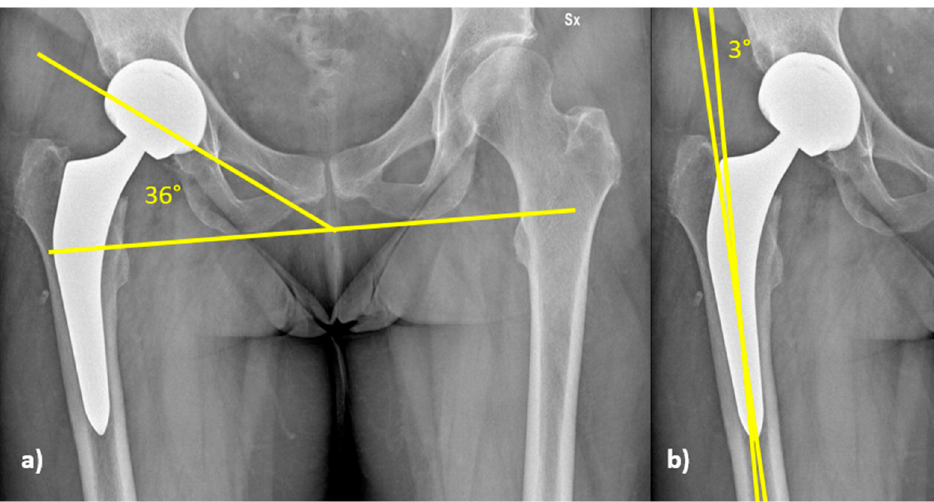
Figure 4. ( a ) Cup inclination is measured as the angle between the line tangent to the border of the acetabular cup and a line parallel to the horizontal plane. ( b ) Stem alignment is the angle between the axis of the stem and of the femur.